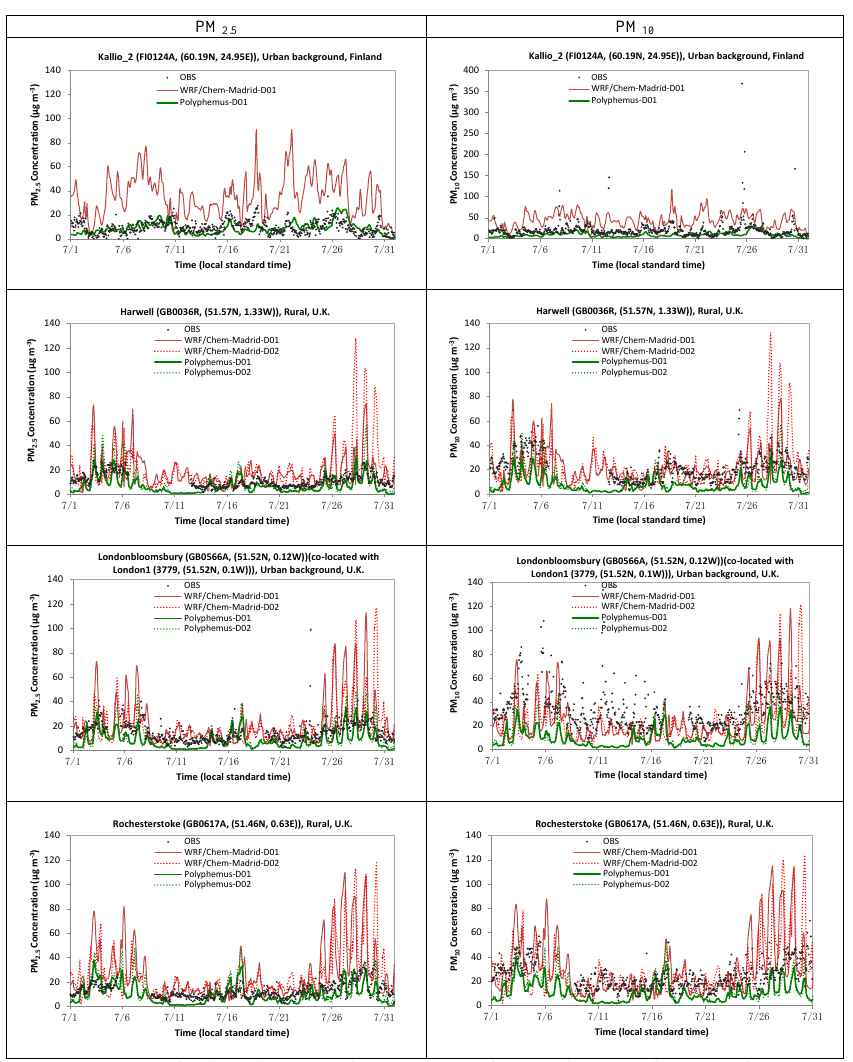
Figure 7. Simulated and observed hourly concentrations of PM 2.5 and PM 10 in July 2001 at selected sites over D01 and D02. Fig. 7. Simulated and observed hourly concentrations of PM 2 . 5 and PM 10 in July 2001 at selected sites over D01 and